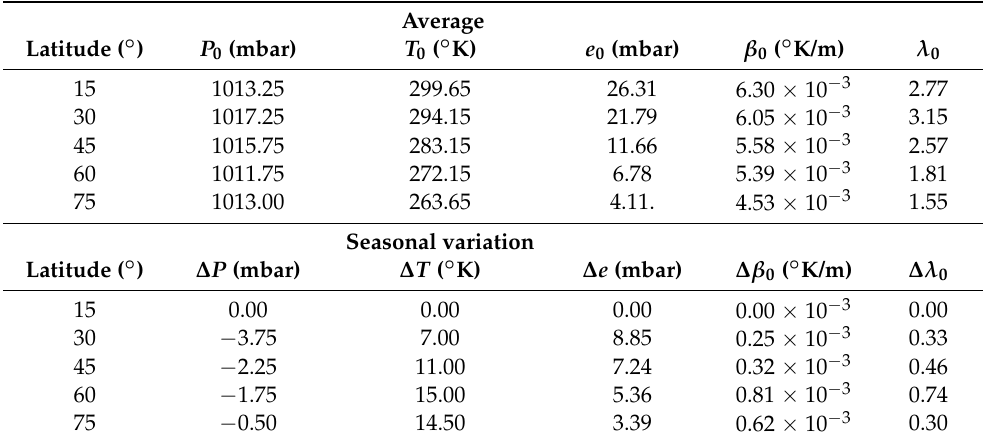
Table 3. Average environmental